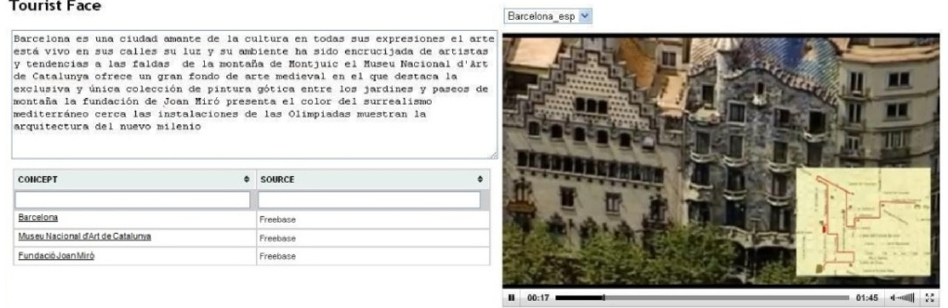
Figure 2. MLTour Platform Interface.